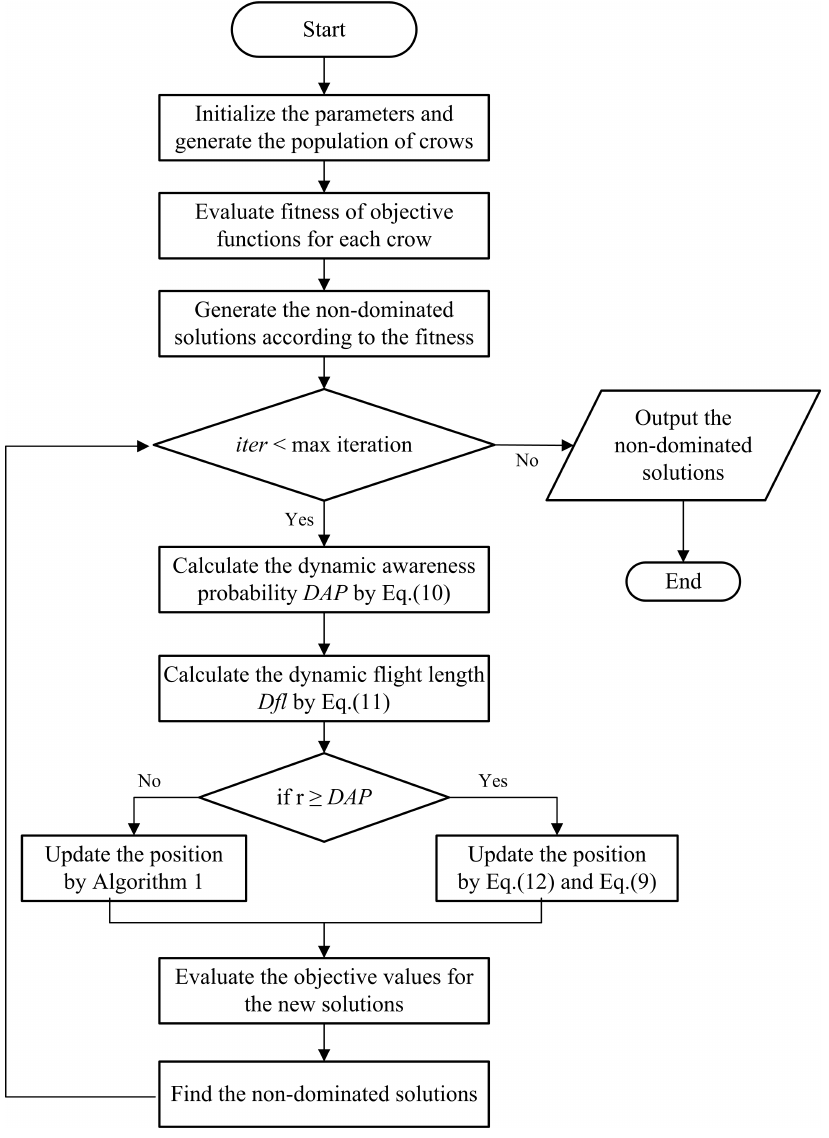
Figure 2. The flowchart of